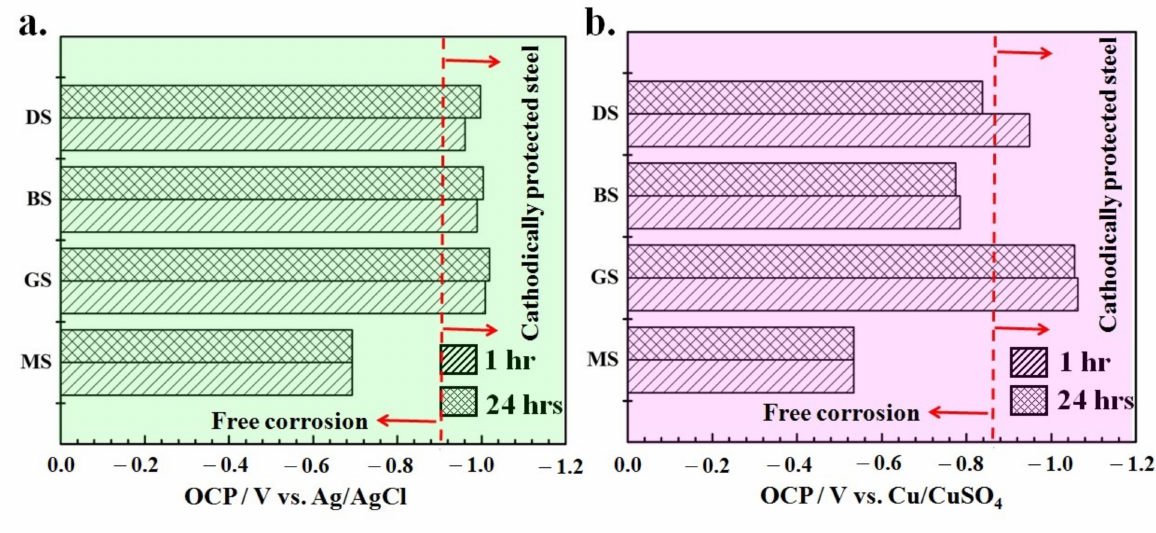
Figure 2. Comparison of the open circuit potential in ( a ) 3.5% NaCl and ( b ) saline soil. The open-circuit potential (OCP) values were measured after 1 and 24 h of